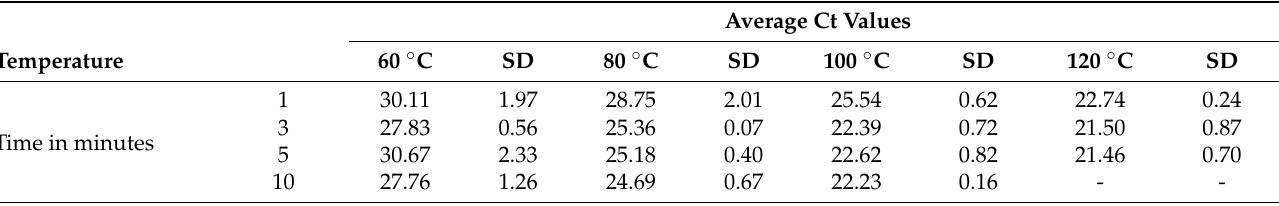
Table 2. Heat treatment for viral